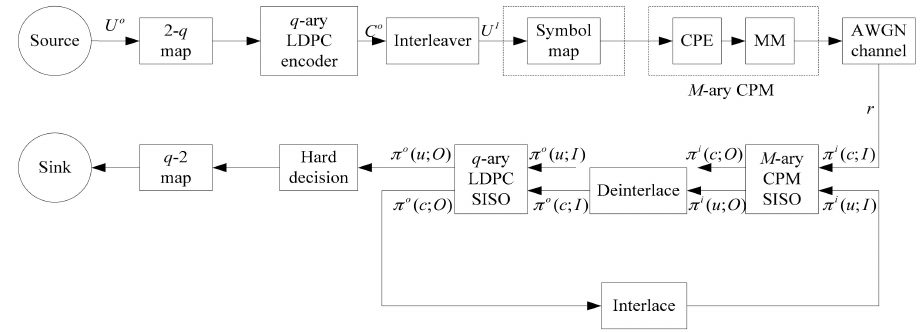
Figure 4. Non-binary LDPC-CPM system